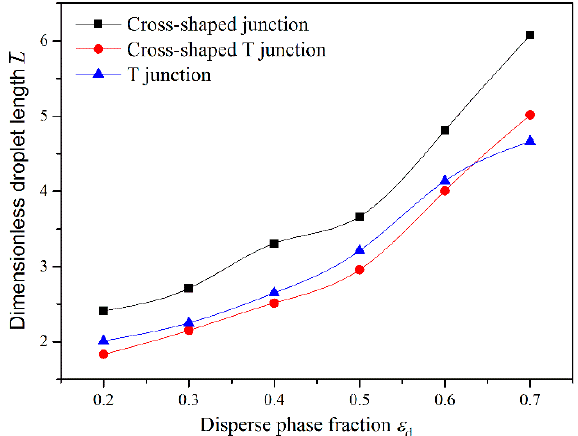
Figure 5. Variation of the dimensionless droplet length with different disperse phase fractions in three